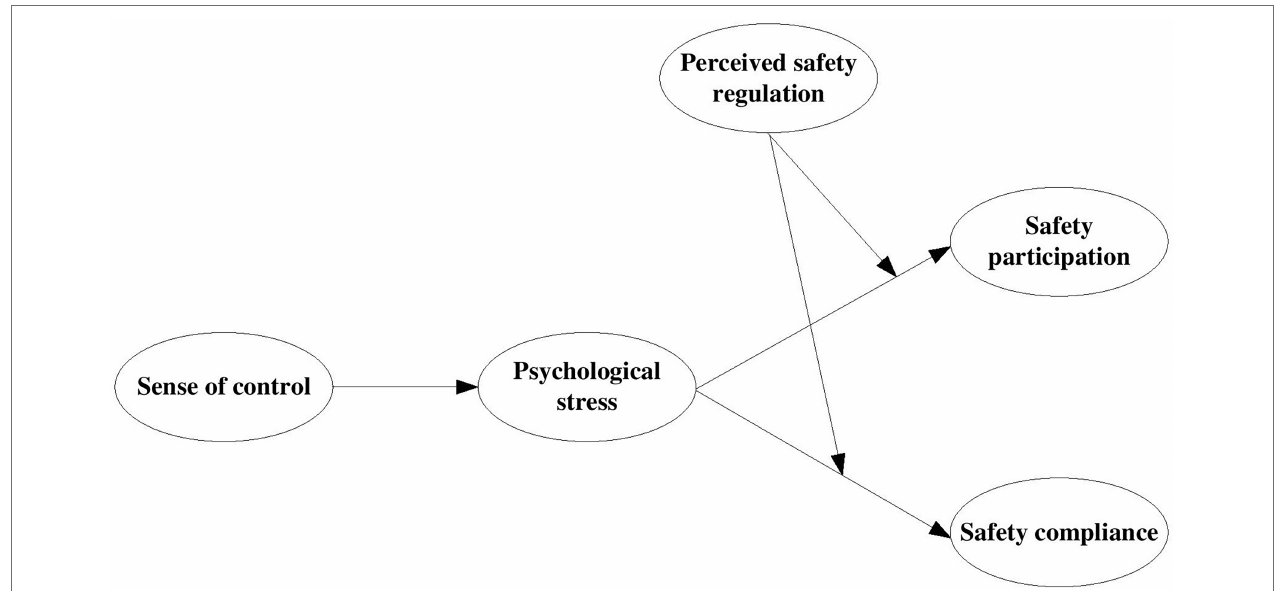
FIGURE 1 | Hypothesized